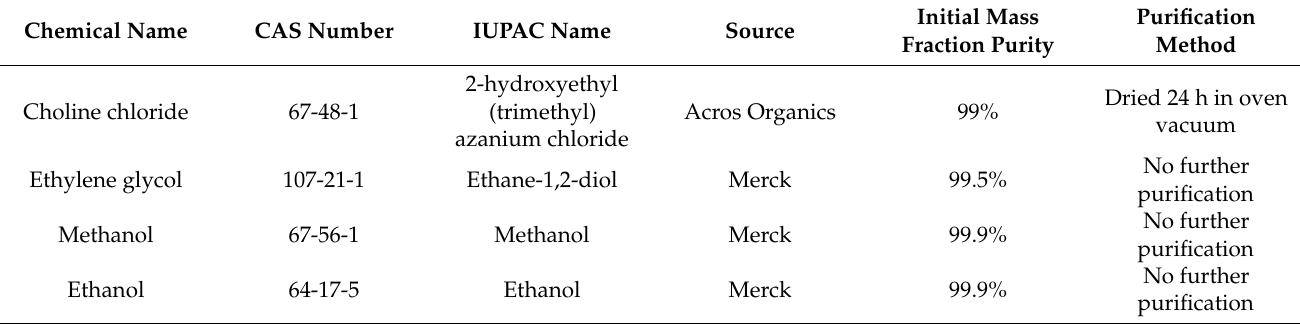
Table 1. Purities, vendors, and purification methods of the chemicals used in this